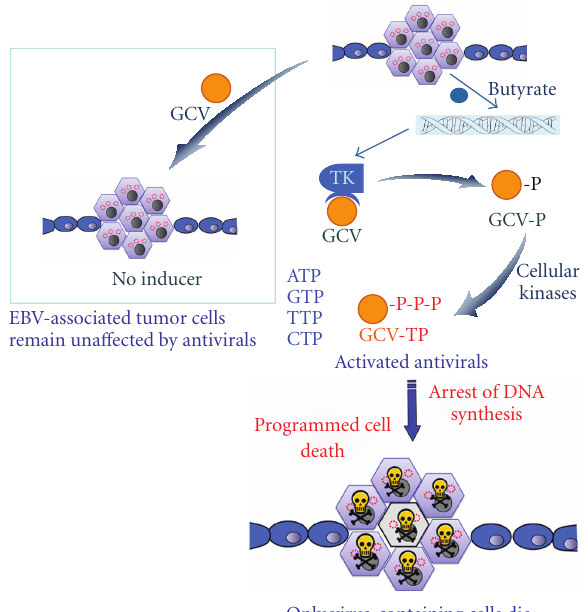
Figure 1: Schematic diagram of combination therapy approaches in EBV malignancies. EBV maintains latent replication in tumor cells and these tumor cells are not susceptible to anti-herpesvirus prodrugs, such as GCV. In the presence of lytic-phase gene expression-inducing agents such as butyrate, the latent EBV expresses thymidine kinase (TK) which converts the prodrug GCV to GCV-P, which is then converted to the (cytotoxic) triphosphate form by cellular kinases. During DNA replication, the triphosphate form of GCV is then incorporated into genomic and viral DNA, causing chain termination, cell-cycle arrest, and apoptosis of the EBV-infected cells.